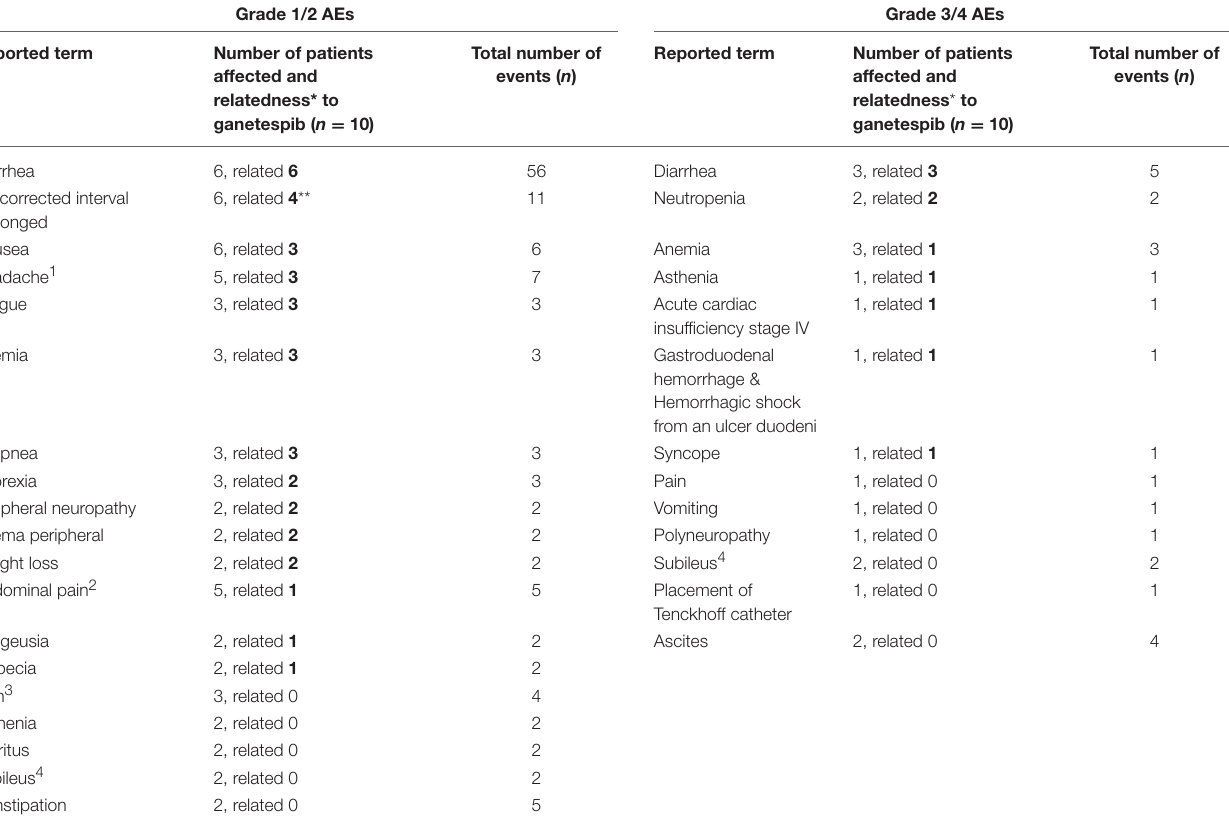
TABLE 3 | Summary of grade 1/2 adverse events (AEs) occurring in > 1 patient and all grade ≥ 3 AEs. Grade 1/2